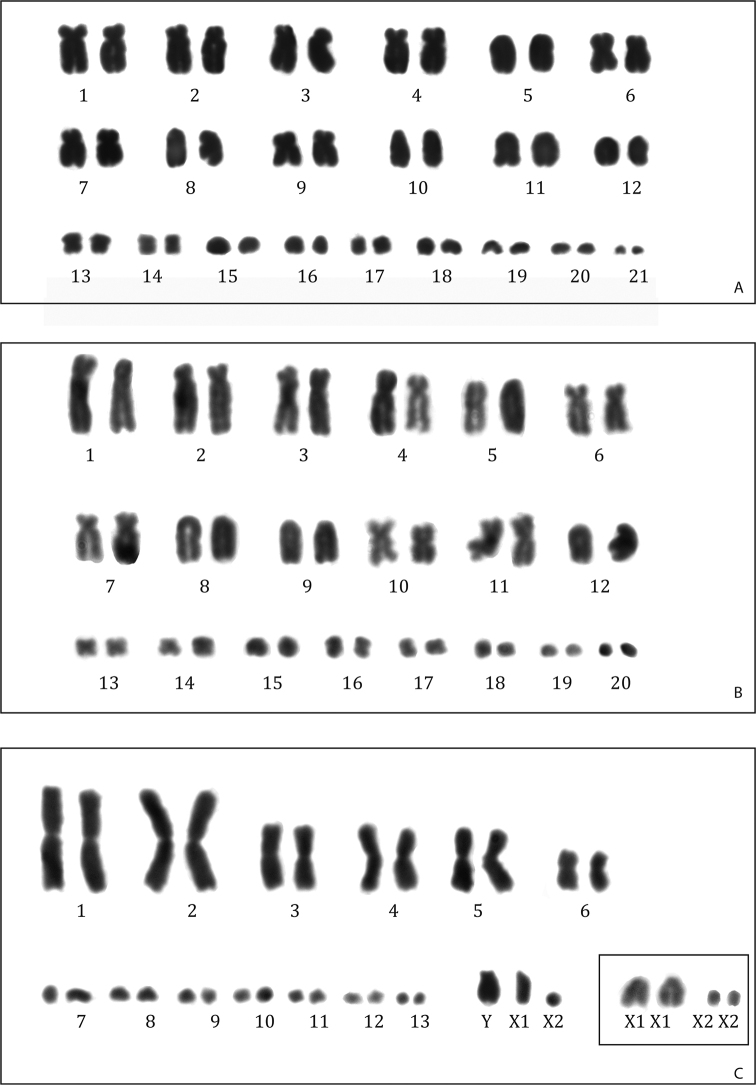
Karyotypes of AAnolis
capito (2n = 40, RCMX218 female) BAnolis
lemurinus (2n = 40, RCMX214 male) and CAnolis
uniformis (2n = 50, RCMX210 male) with YX1X2 sex chromosomes; in the box the X1X1X2X2 (RCMX206 female) sex chromosomes.